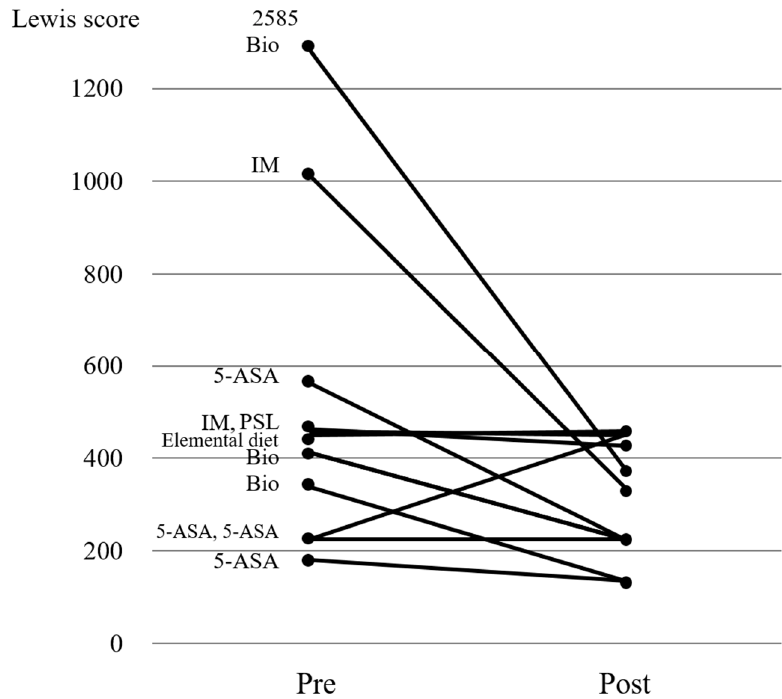
Figure 4. Changes in the Lewis scores in asymptomatic patients before and after treatment. Bio, biologic; IM, infliximab; 5-ASA, 5-aminosalicylic acid; PSL, prednisolone; pre, pre-treatment; post, post-treatment.